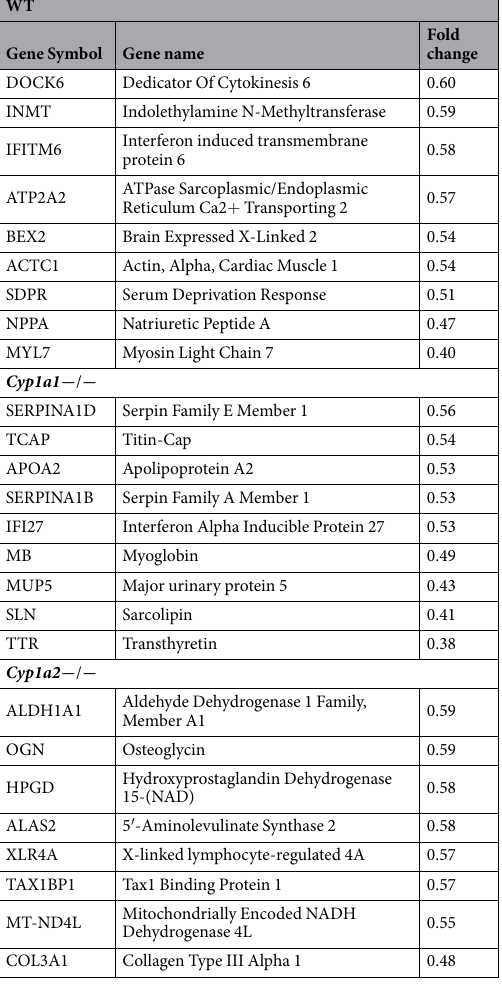
Table 2. Down regulated genes exclusive to a given genotype (Hyperoxia exposed mice compared to room air Cyp1a2 − / − mice showed decreased expression levels compared to WT mice under hyperoxic conditions. Cyp1a2 − / − mice exhibited consistently the lowest expression for these genes among the three genotypes. Among genes involved in response to hypoxia: Hmox1 and Ctgf were induced by hyperoxia with increasing expression with increasing duration of hyperoxia exposure. The induction was very significant in WT mice and to a lesser extent in Cyp1a1 − / − mice, and the least induction was observed in Cyp1a2 − / − mice. Slc2a3 was induced at 72 h in WT and Cyp1a1 − / − mice compared to room air controls but decreased expression was seen in Cyp1a2 − / − mice compared to other genotypes. However, expression of Dusp1 was significantly increased in Cyp1a2 − / − mice at 24 and 72 h compared to other genotypes and respective room air controls. We validated Cd63 and Abca1 as part of the protein secretion pathway. Cd63 was induced under hyperoxia in all three genotypes but was most significant in WT mice and the least in Cyp1a2 − / − mice. On the other hand, expression levels of Abca1 decreased under hyperoxic conditions in all three genotypes but this was more signif- icant in the Cyp1a1 − / − and Cyp1a2 − / − mice compared to WT mice at 72 h. Areg (early response to Estrogen pathway) expression was increased at 48 and 72 h in all three genotypes after hyperoxia exposure at 48 and 72 h. Expression was higher in Cyp1a2 − / − mice at 48 h but at 72 h, WT mice had higher expression levels compared to Cyp1a1 − / − and Cyp1a2 − / − mice. Trp63 (Apoptosis pathway) did not show significant change in expression with hyperoxia. The expression was decreased in Cyp1a2 − / − mice at 24 h compared to WT mice. Expression levels of Ankrd1 , Gdf15 and Nupr1 were significantly increased in all three genotypes at 48 and 72 h compared to room air controls. At 72 h, the expression was lower in Cyp1a1 − / − and Cyp1a2 − / − mice compared to similarly exposed WT mice. There were excellent correlations in fold changes measured by real time PCR and by microarray for the experi- mentally validated genes, as shown in Table 3. The Pearson Correlation Coefficient for fold change in gene expres- sion was 0.85 for WT, 0.84 for Cyp1a1 − / − and 0.78 for Cyp1a2 − / − mice.